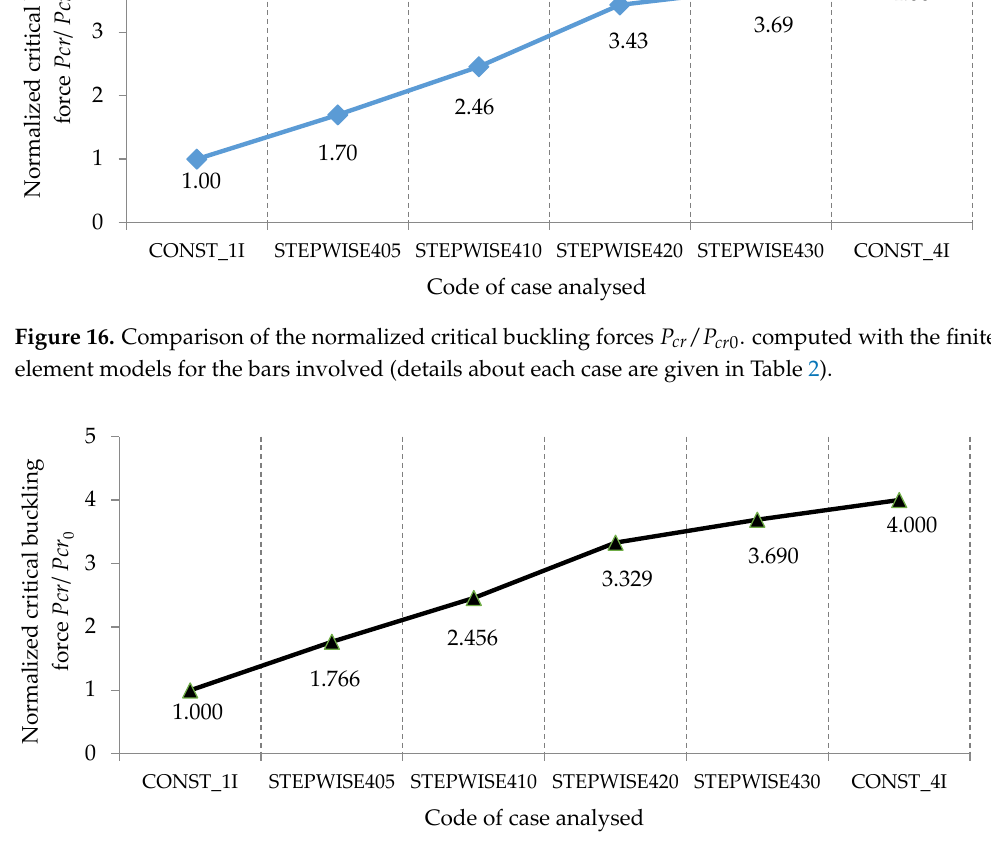
Figure 17. Comparison of the normalized critical buckling forces P cr / P cr 0 computed with the analytical model for the bars involved in this research (details about each case are given in Table 2).